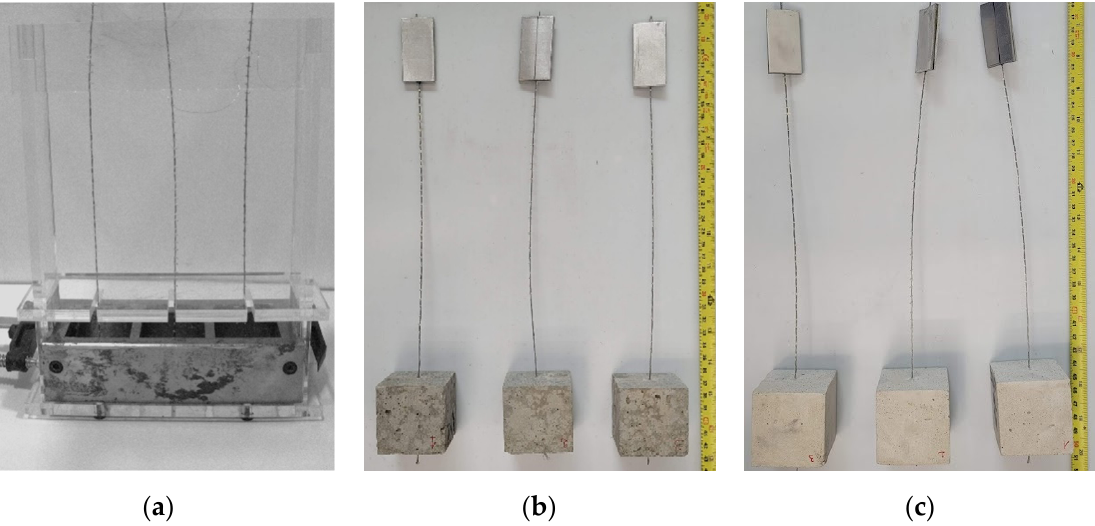
Figure 3. Manufacturing procedure for the pull-out tests. ( a ) Single cords positioned in a bespoke acrylic frame and steel mold. ( b ) ‘HW-GLT’ specimens equipped with tabs. ( c ) ‘HW-GCF’ specimens equipped with tabs .